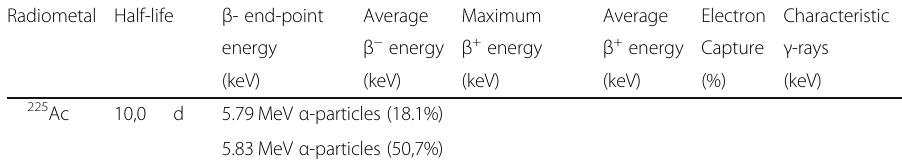
Table 1 Emerging radiometals and their nuclear properties (Continued) Radiometal